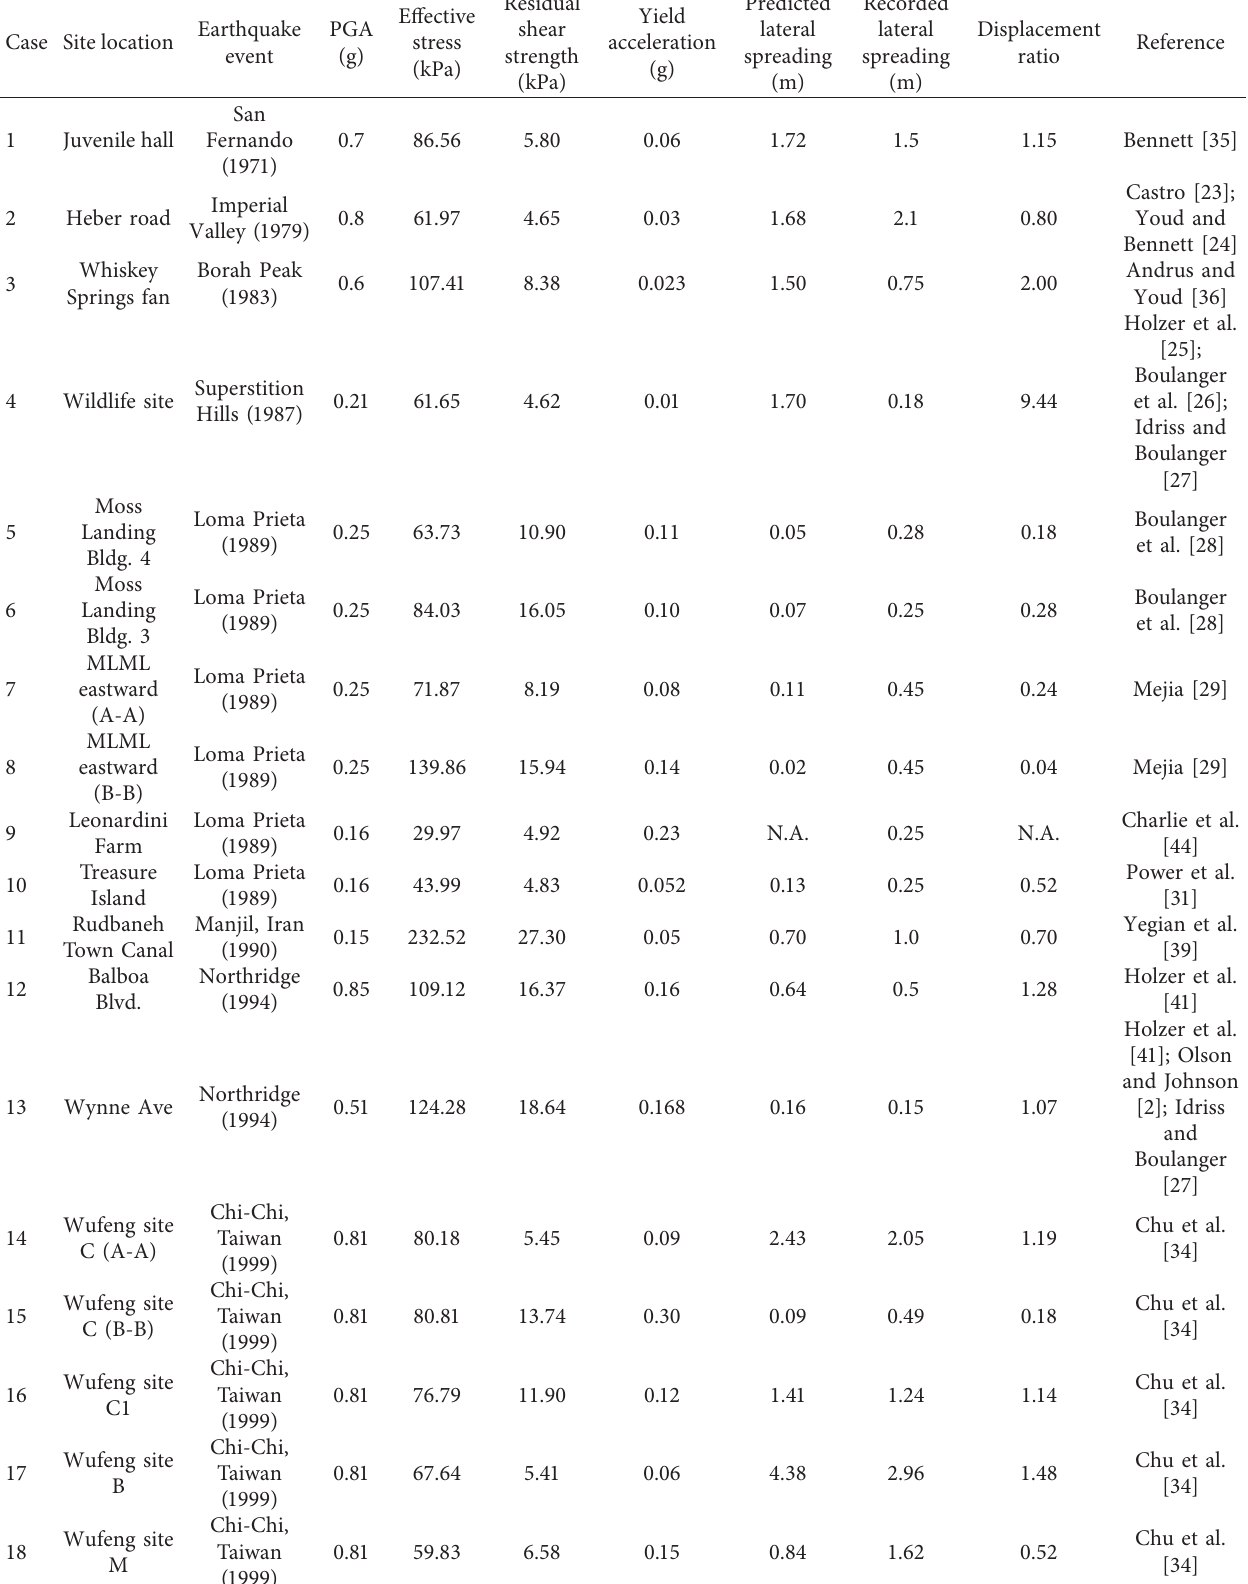
Table 3: The average predicted and recorded lateral spreading for each case